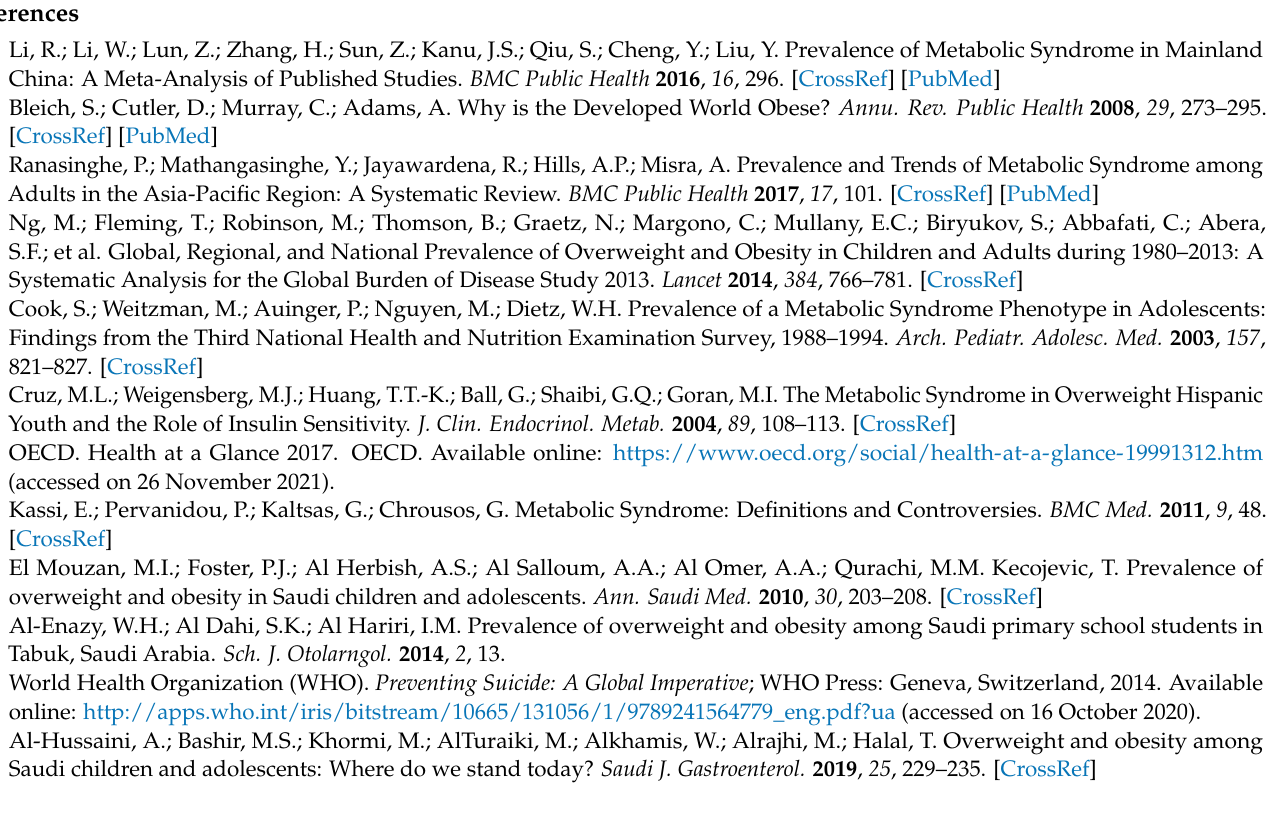
Table S2: Prevalence of MetS components in 2010, 2015, and 2019 in boys and